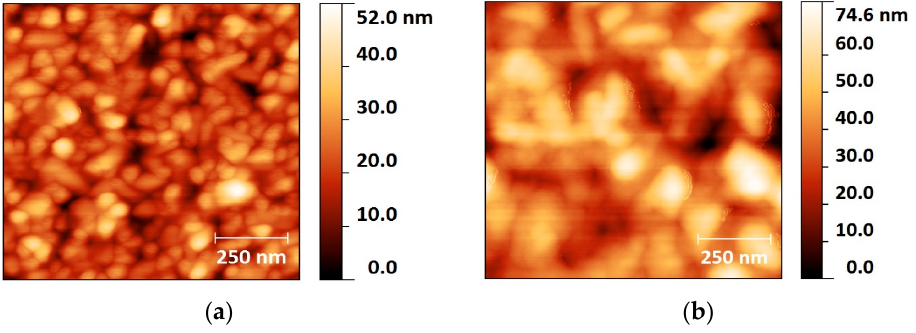
Figure 3. AFM images of the surface of AZO layer deposited at ( a ) RT and ( b ) 300 °C.